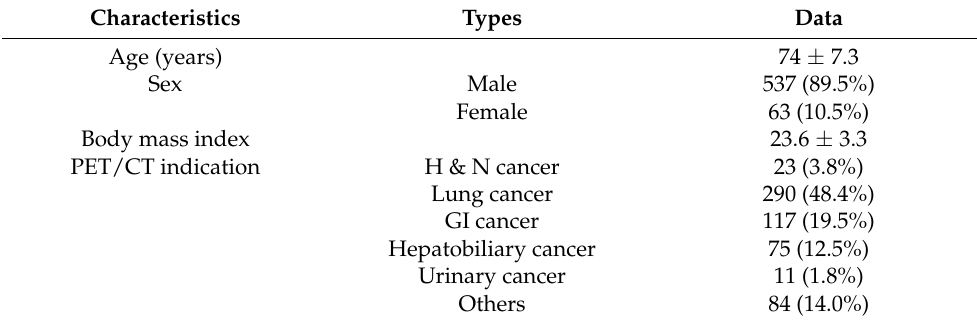
Table 4. Patient